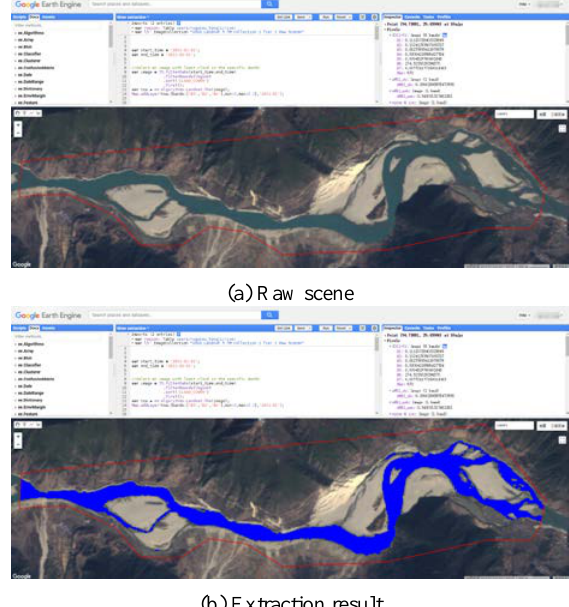
Figure 3. Flowchart for water extraction with Landsat images .